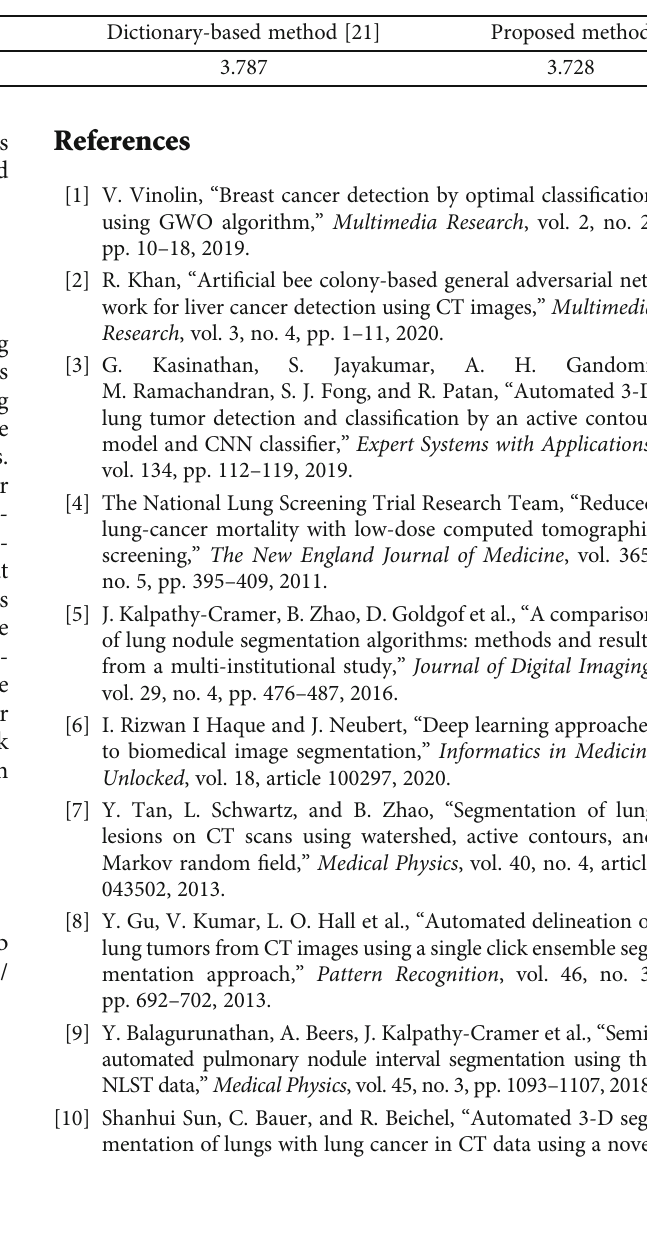
Table 3: Comparison of memory requirements.